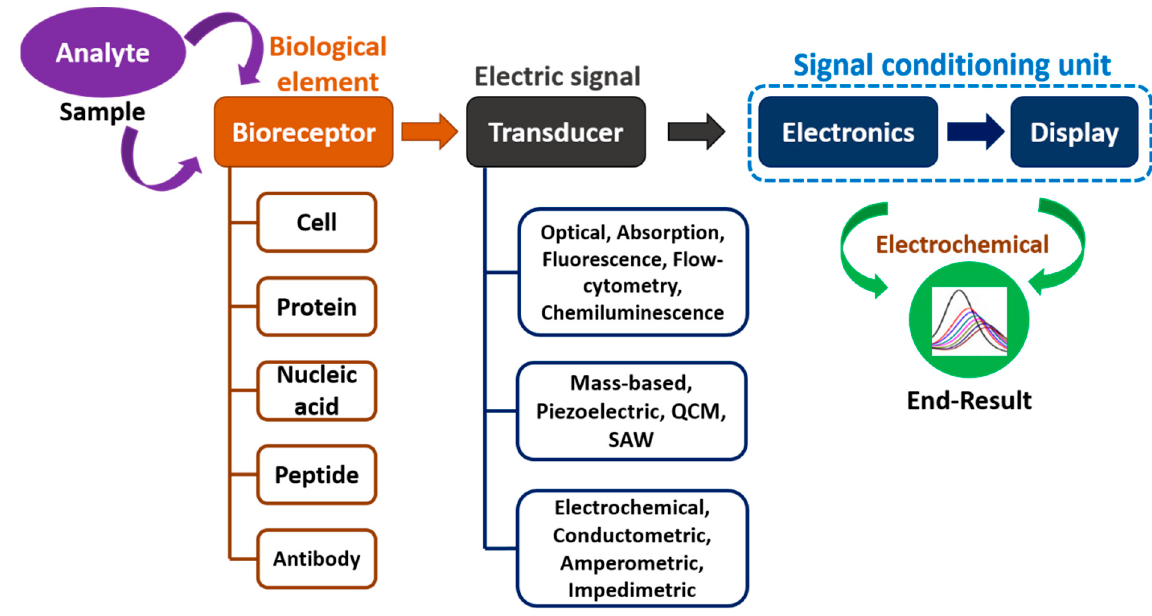
Figure 1. Block diagram representation of biosensors: from analyte to detection.